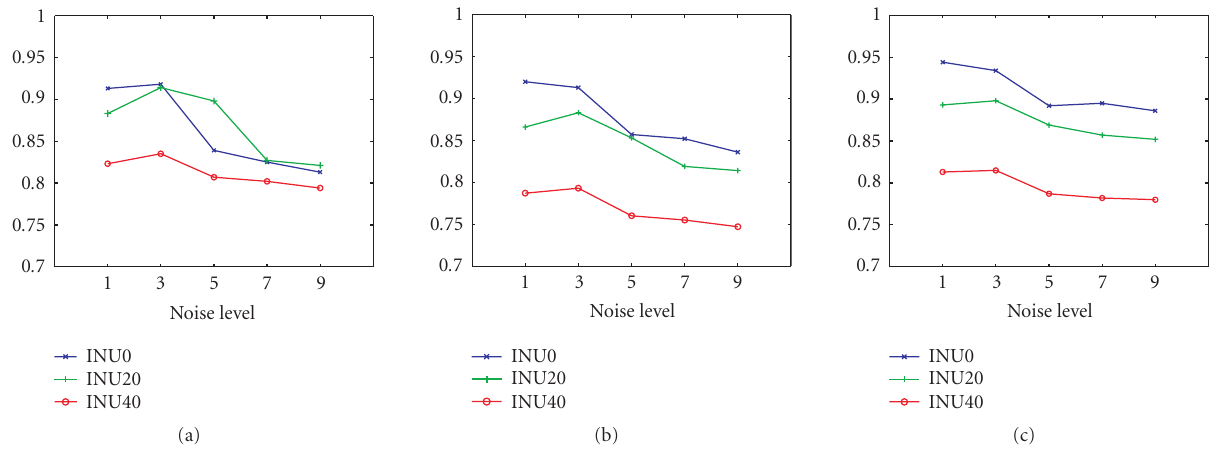
Figure 10: Overlap metric for CSF, GM, and WM segmentations on simulated brain images provided by BrainWeb website. The di ff erent noise levels are 1%, 3%, 5%, 7%, and 9%. The three curves labeled INU0, INU20, and INU40 represent the overlap metric of the segmenta- tion results of the images with 0%, 20%, and 40% INU settings based on our proposed method. (a) The overlap metric of CSF segmentation results for images with di ff erent noise levels (1%, 3%, 5%, 7%, and 9%) and di ff erent INU settings (0%, 20%, and 40%). (b) The overlap metric of GM segmentation results for images with di ff erent noise levels (1%, 3%, 5%, 7%, and 9%) and di ff erent INU settings (0%, 20%, and 40%). (c) The overlap metric of WM segmentation results for images with di ff erent noise levels (1%, 3%, 5%, 7%, and 9%) and di ff erent INU settings (0%, 20%, and 40%).